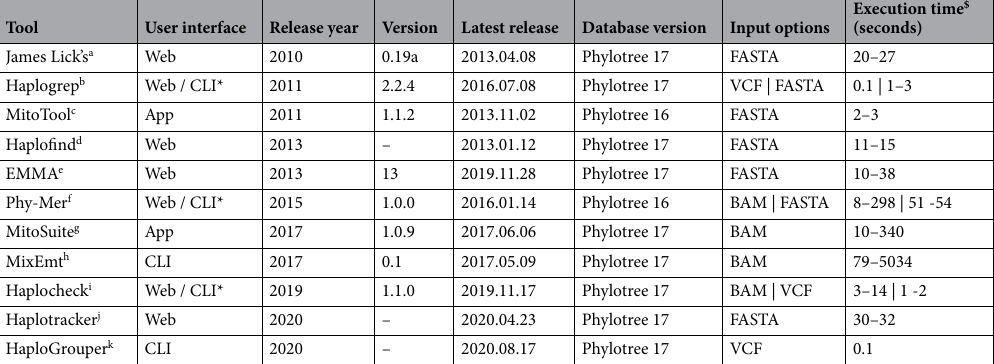
Table 1. List of software assessed for human mtDNA haplogroup classification. All the tools assessed classify mtDNA sequences according to the PhyloTree nomenclature by using the latest version Build 17. Two of them, MitoTool and Phy-Mer, remain outdated in regards of the PhyloTree built when this study was conducted. * CLI Command-line interface. $ A range is provided given the differences among samples in the size of